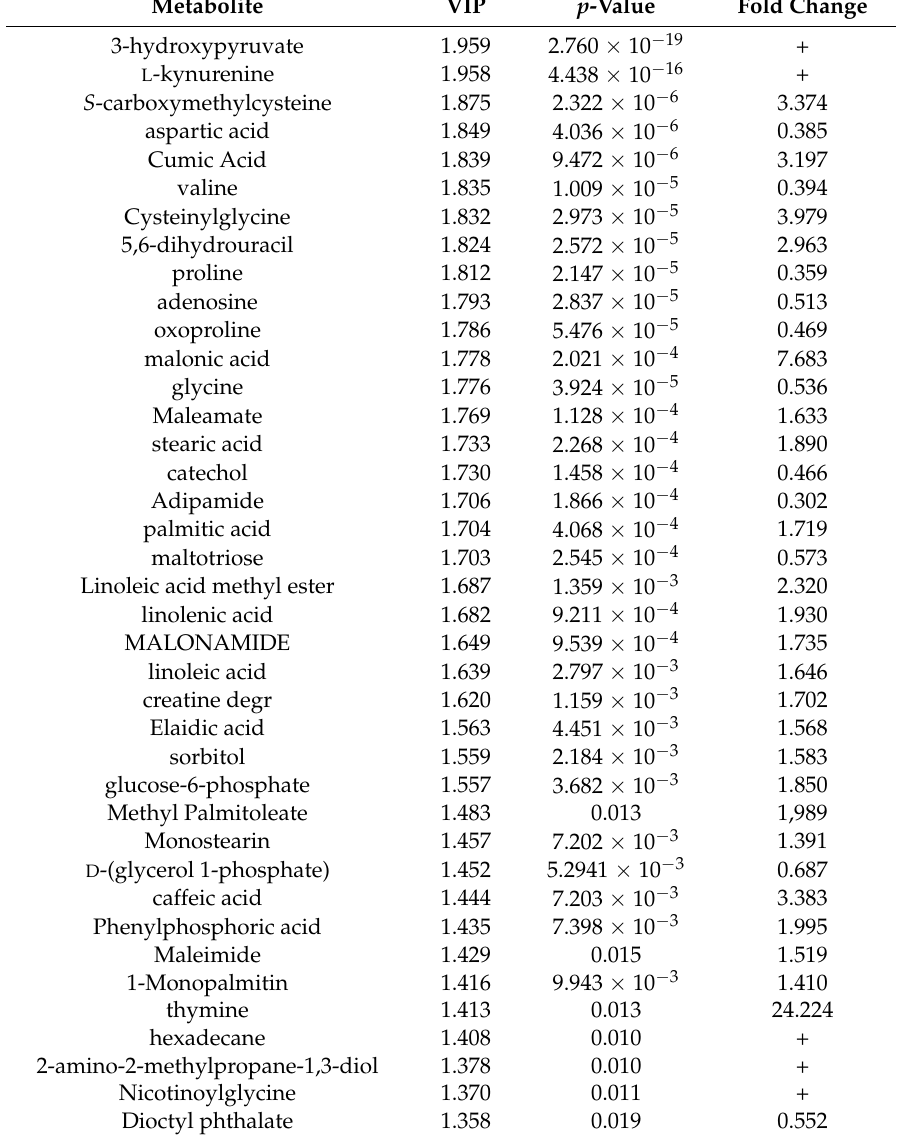
Figure 3. Orthogonal partial least squares-discriminant analysis (OPLS-DA) of metabolites derived from GC-MS. ( A ): 47 days after pollination (DAPs); ( B ): 63 DAPs. Table 1. Differential metabolites at 47 DAPs in Wonhwang’ (DW) and ‘Jingbaili’ (DJ). Metabolite VIP p -Value Fold Change